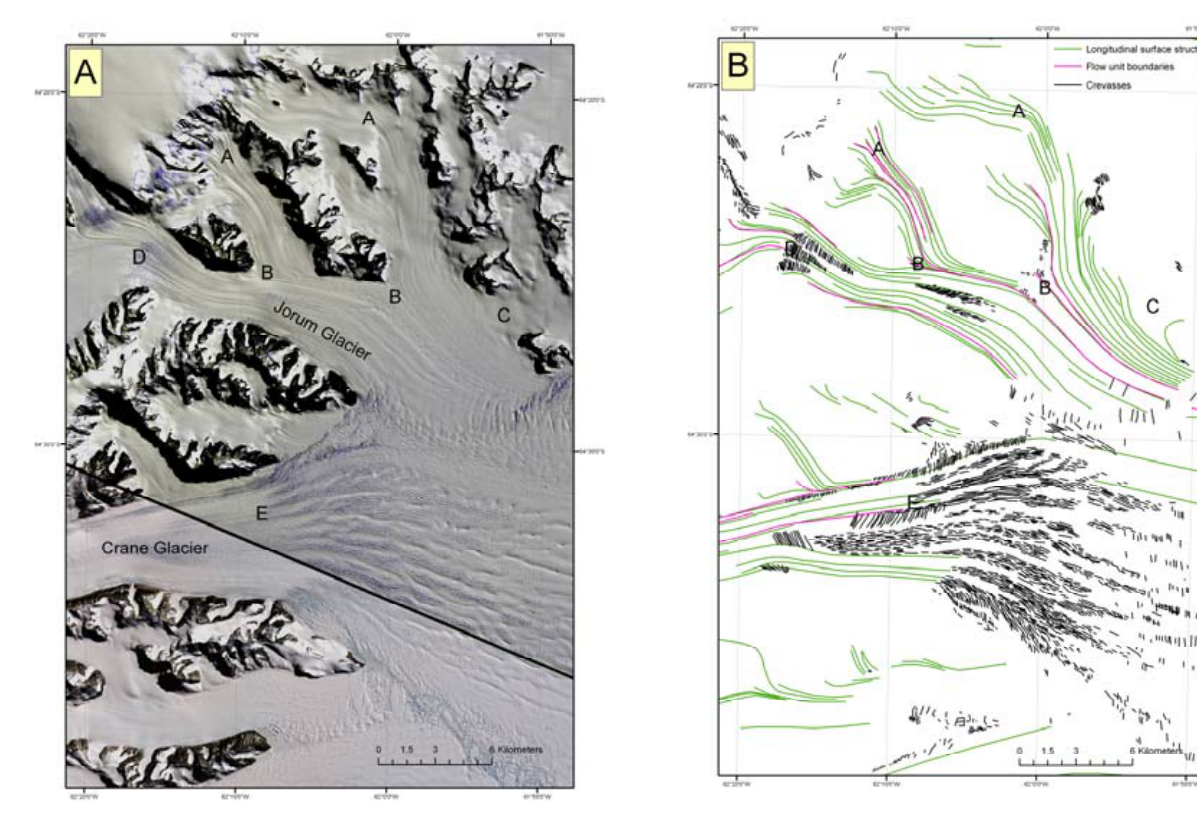
Fig. 4a. Portion of ASTER image from November 2001 showing Crane and Jorum Glaciers on the eastern side of the Antarctic Penin- Figure 4A. Portion of ASTER image sula flowing into the former Larsen B Ice Shelf prior to its rapid Figure 4A. Portion of ASTER image disintegration in February–March 2002. from November 2001 showing from November 2001 showing Crane and Jorum Glaciers on the Crane and Jorum Glaciers on the eastern side of the Antarctic eastern side of the Antarctic Peninsula flowing into the former Peninsula flowing into the former Larsen B Ice Shelf prior to its rapid Larsen B Ice Shelf prior to its rapid